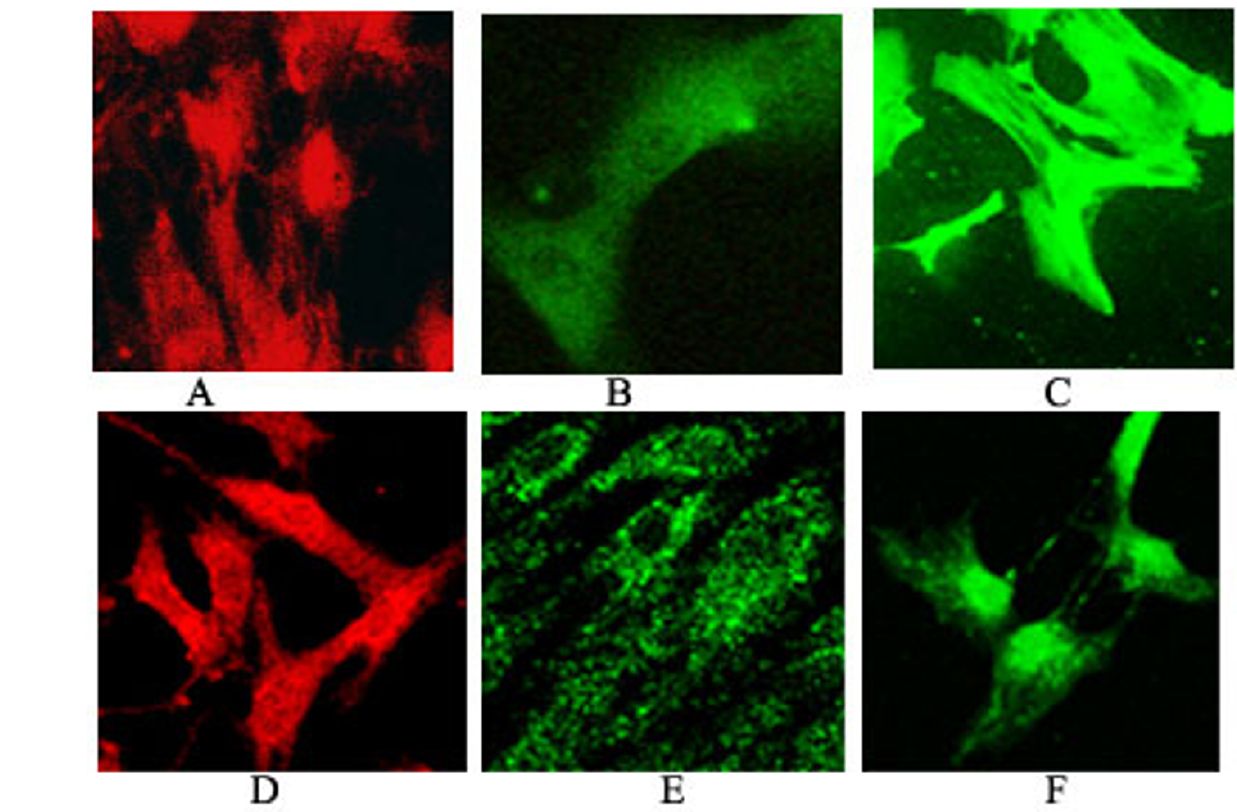
Figure 2 Primary cell cultures human smooth muscle cells. (A-D, Bak): (A) Bak in control cells (magnification 800×) (D) Bak in presence of 20 µ M xanthurenic acid (magnification 800×), (B-E, Bclx presence of 10 µ M xanthurenic acid (magnification 1260×), (C-F, Bad): (C) Bad in control cells (magnification 800×), (F) Bad 20 µ M xanthurenic acid (magnification